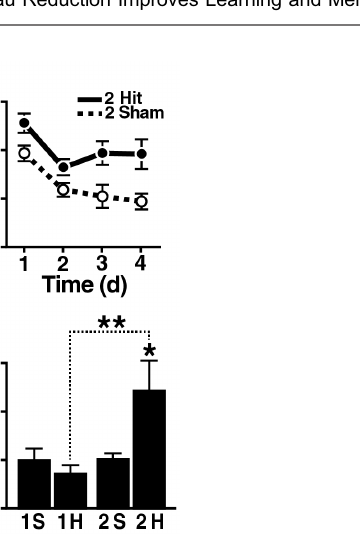
Fig. 1. Wildtype mice show learning and memory deficits one month after 2-hit frontal injury. Wildtype mice (n 5 9–10 per group) received a 1-hit or a 2-hit frontal impact injury or sham treatments, and were tested in the Barnes maze one month later. (A, B) Learning curves of the 1-hit (A) and 2-hit (B) groups, reflecting the time it took mice to find the target, averaged from 2 trials per day. Only the 2-hit group differed significantly from sham-treated controls (p 5 0.0062 by linear mixed effects model analysis). (C) The 2-hit group and sham- treated controls showed a comparable latency to target during the first trial on the first training day. (D) Probe trial administered 24 h after the last training trial. *p , 0.05, **p , 0.01 vs corresponding sham group or as indicated by bracket. Sh, Sham; H, Hit. Data are means ¡ SEM.